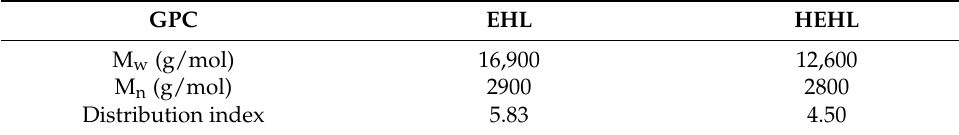
Table 2. Gel permeation analysis for EHL and HEHL.